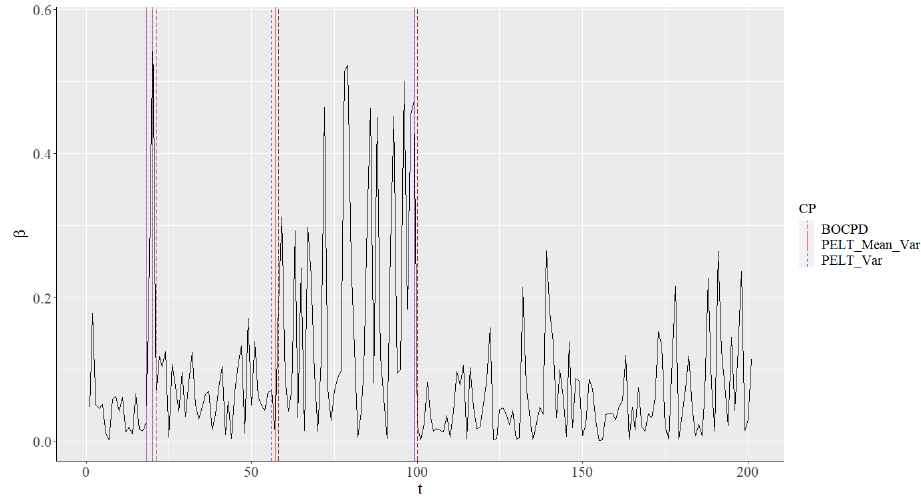
Figure 7. Detection of CPs in the simulated transmission rate ( BOCPD ( m ) = 3, PELT _ Mean _ Var ( m ) = 4, PELT _ Var ( m ) = 4).